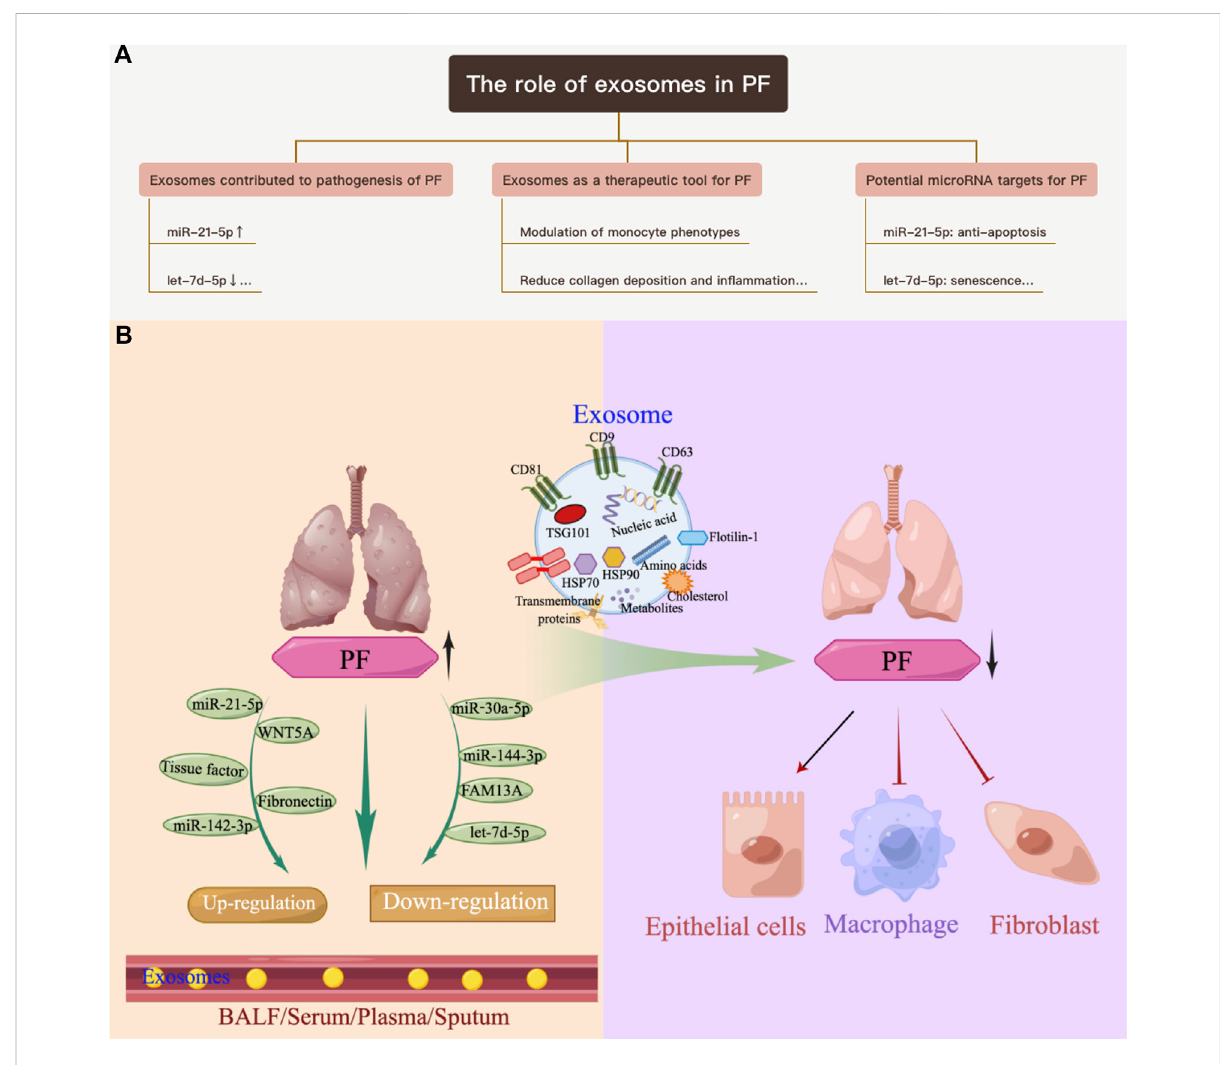
FIGURE 1 Overview of the role of exosomes in PF. (A) Exosomes contribute to the pathogenesis of PF. (B) Exosomes as a therapeutic tool for pulmonary PF.